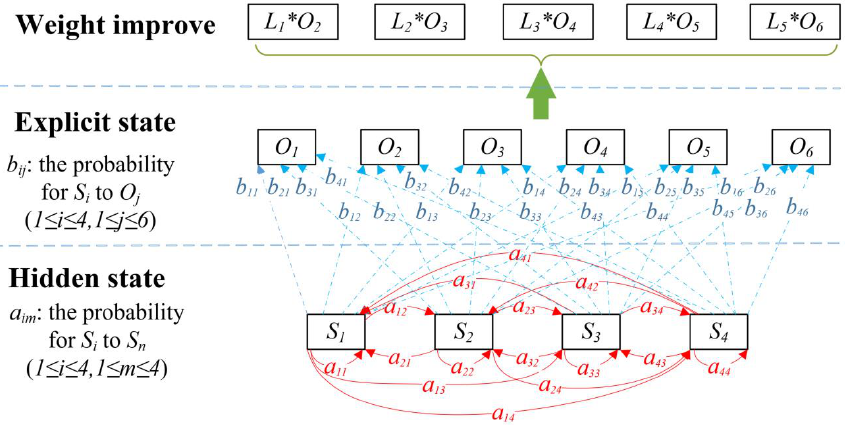
Figure 4. The W-HMM